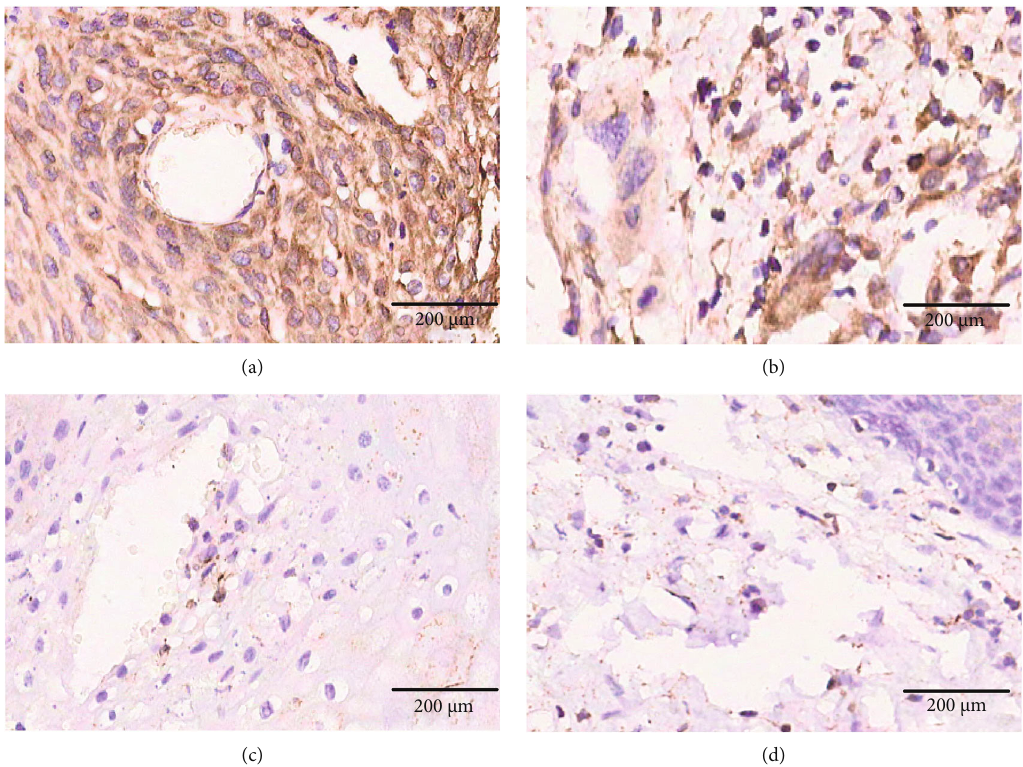
Figure 4: Expression of PDIA3 in cervical cancer and adjacent cancer tissues (IHC 200 × ). (a) and (b) The positive expression of PDIA3 protein in cervical cancer samples. (c) and (d) The negative expression of PDIA3 protein in normal tissue